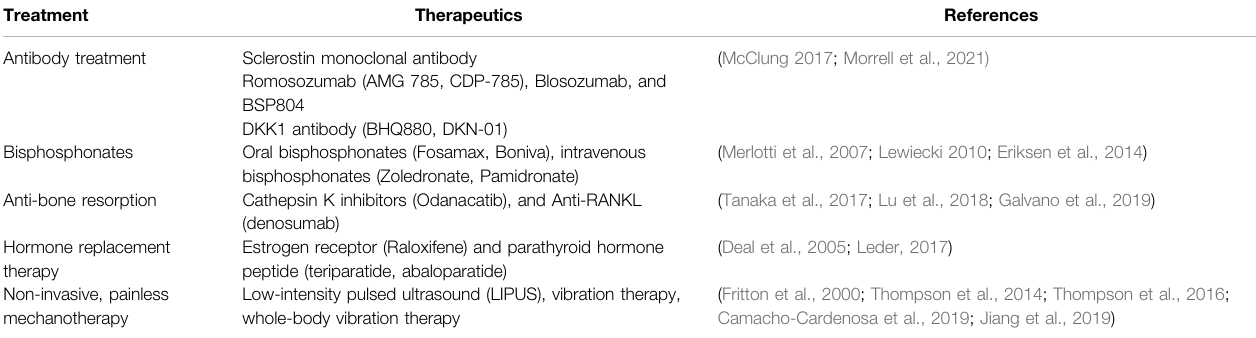
TABLE 3 | Treatment options for osteocyte-related